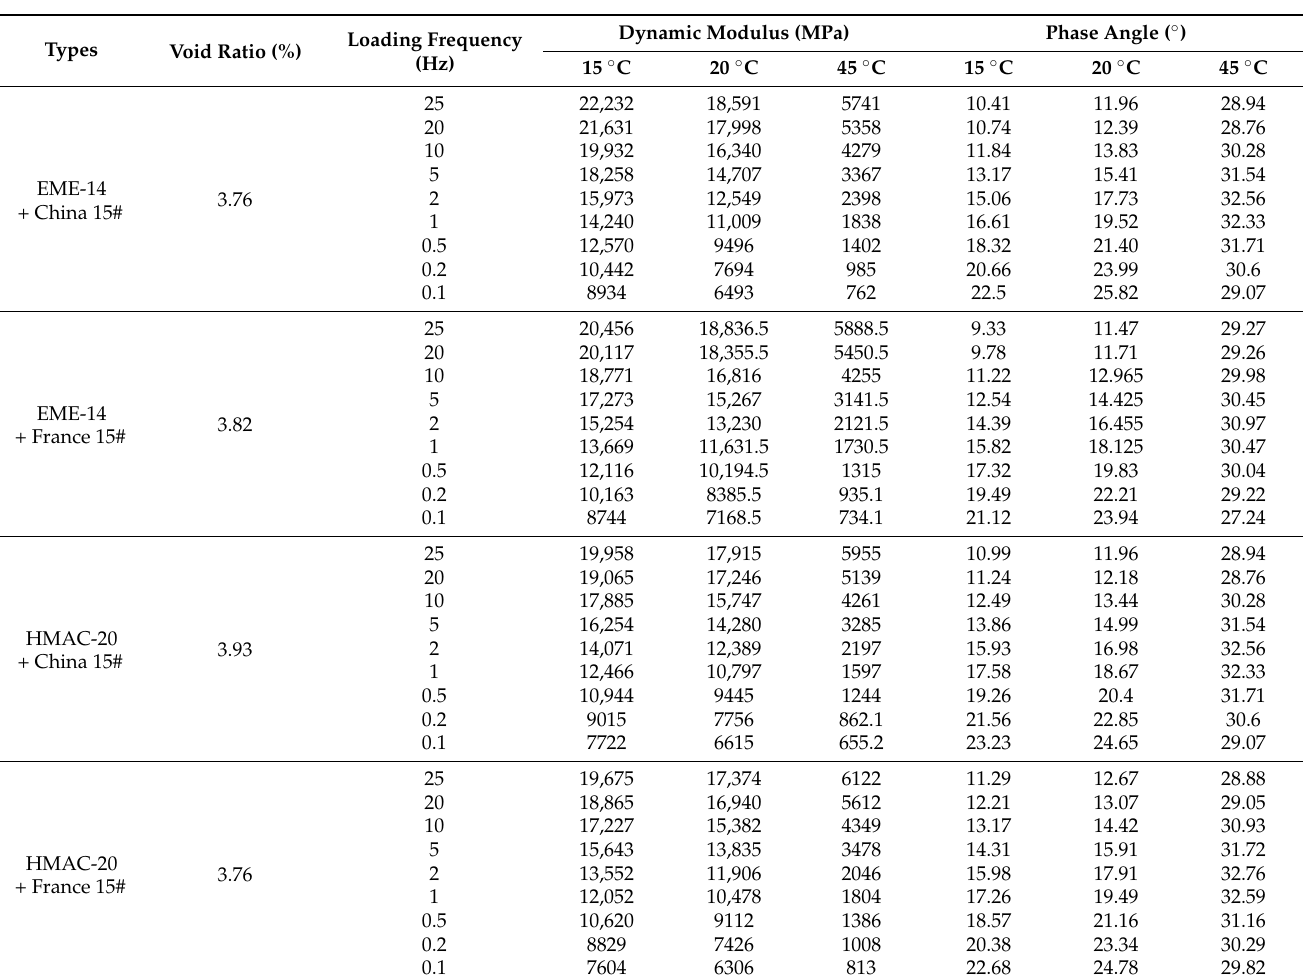
Table 9. Dynamic modulus results of different types of low-mark high-modulus